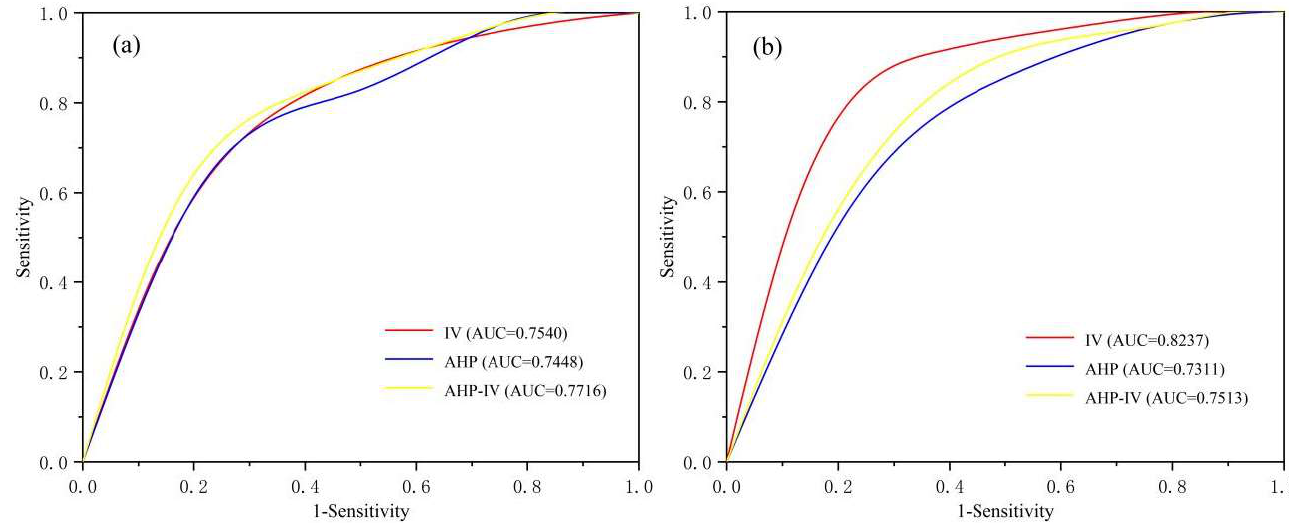
Figure 5. ROC curve of LSA: ( a ) Models in RS; ( b ) Models in NRS.